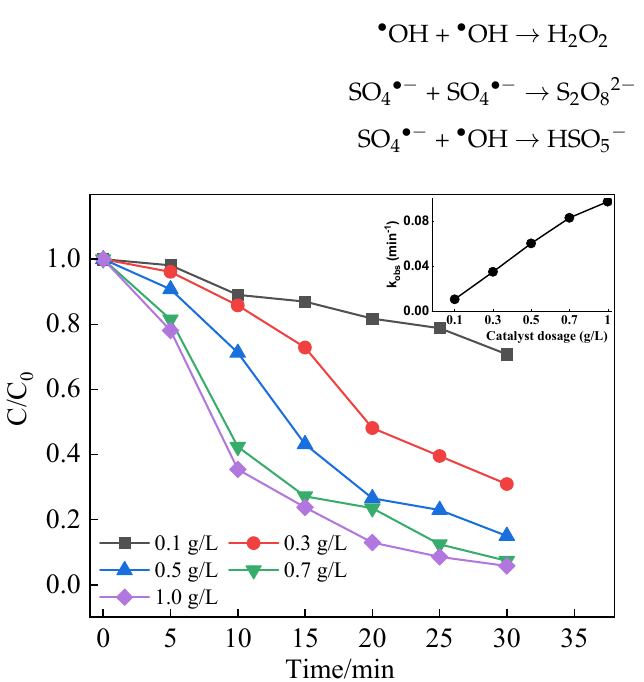
Figure 5. Effect of catalyst dosage on BPA removal. Conditions: C 0 = 0.05 mM, [PMS] = 10 mM, pH 0 6.8.